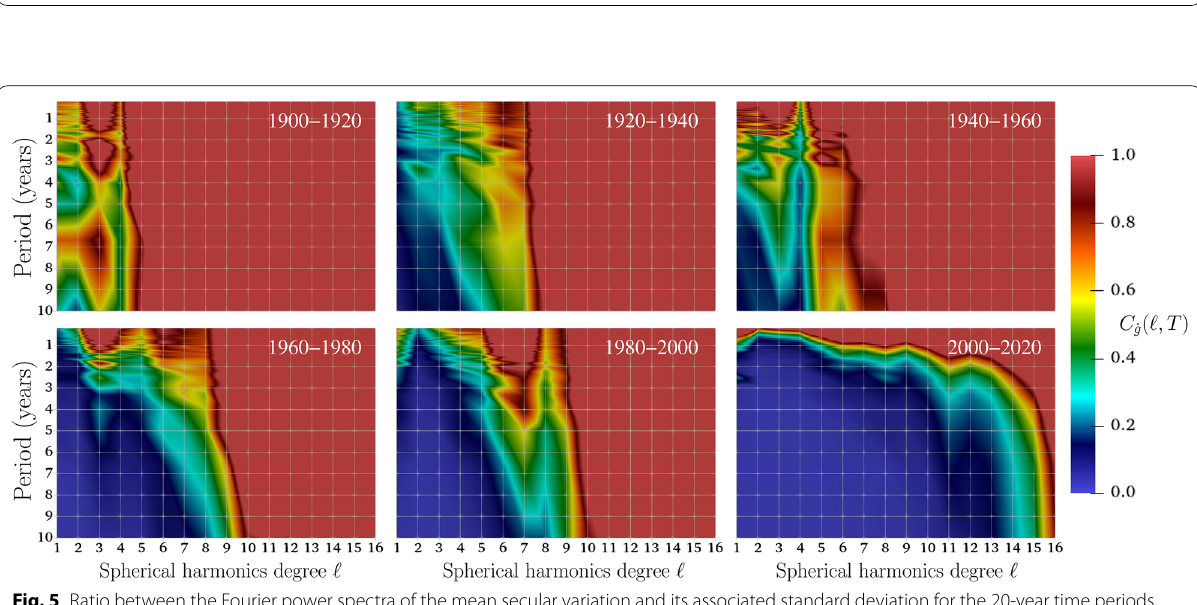
Fig. 5 Ratio between the Fourier power spectra of the mean secular variation and its associated standard deviation for the 20‑year time periods displayed on the top right of each